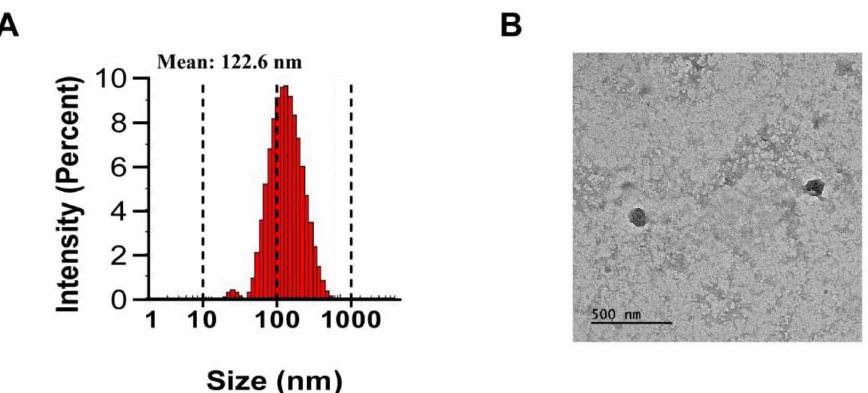
Figure 1. Isolation and characterization of extracellular vesicles (PJ-EVs) derived from the leaves of Petasites japonicus . ( A ) Size distribution of PJ-EVs was determined by dynamic light scattering (DLS) analysis. The graph shows results obtained in the with DLS analysis. ( B ) Morphology of PJ-EVs visualized by transmission electron microscopy (TEM). Scale bar = 500